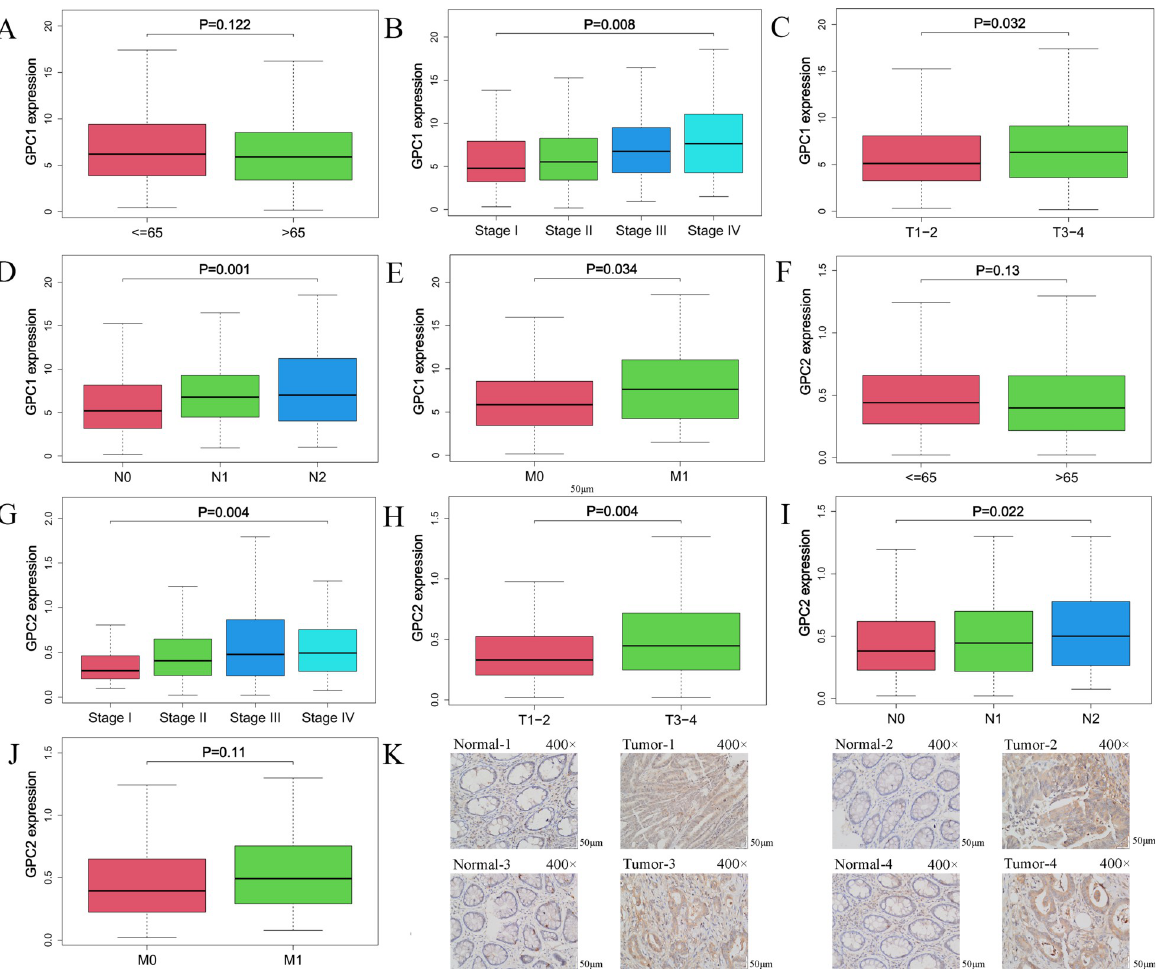
Fig 2. Elevated expression of GPC1 is associated with clinicopathological features of CRC. (A–J). GPC1 and GPC2 mRNA expression analysis in TCGA CRC samples (453 samples) by age, stage, T, N and M using Kolmogorov–Smirnov test. (K). Immunohistochemical staining for GPC1 in CRC tissues and normal